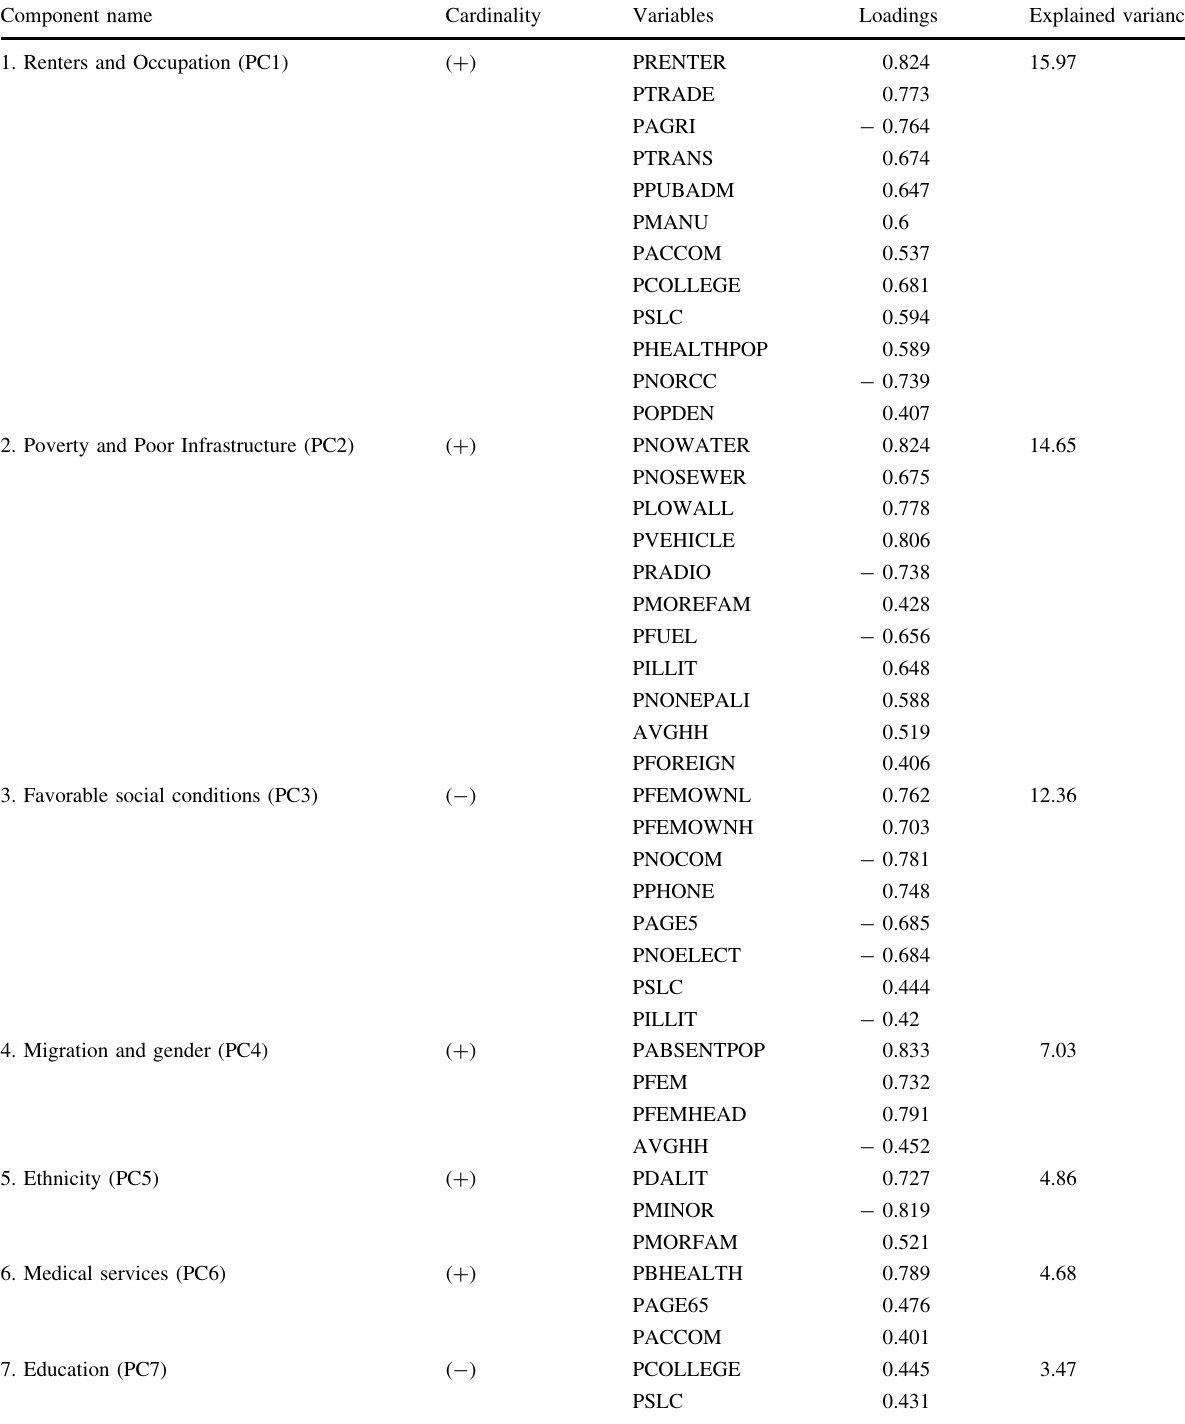
Table 2 Principal components (PC), cardinality, variables, loadings, and explained variance for the modified Social Vulnerability Index in